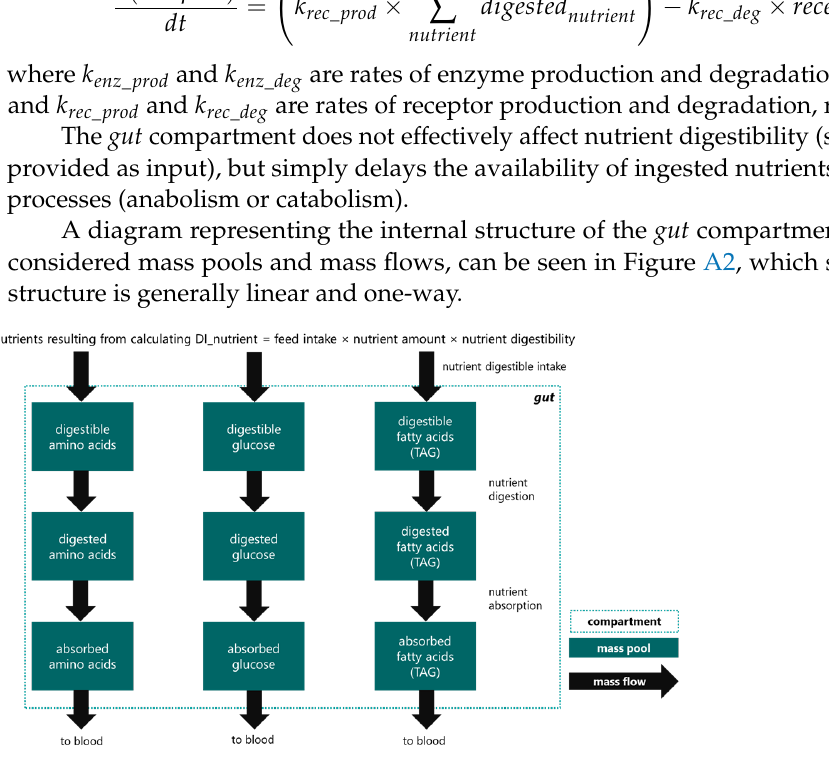
Figure A2. Diagram detailing the internal structure of the gut compartment, showing the different pools considered, along with mass flows between pools. For simplicity, the amino acid and fatty acid pools are displayed in vectorized form (i.e., they appear as a single unit, but actually represent 20 different pools each).